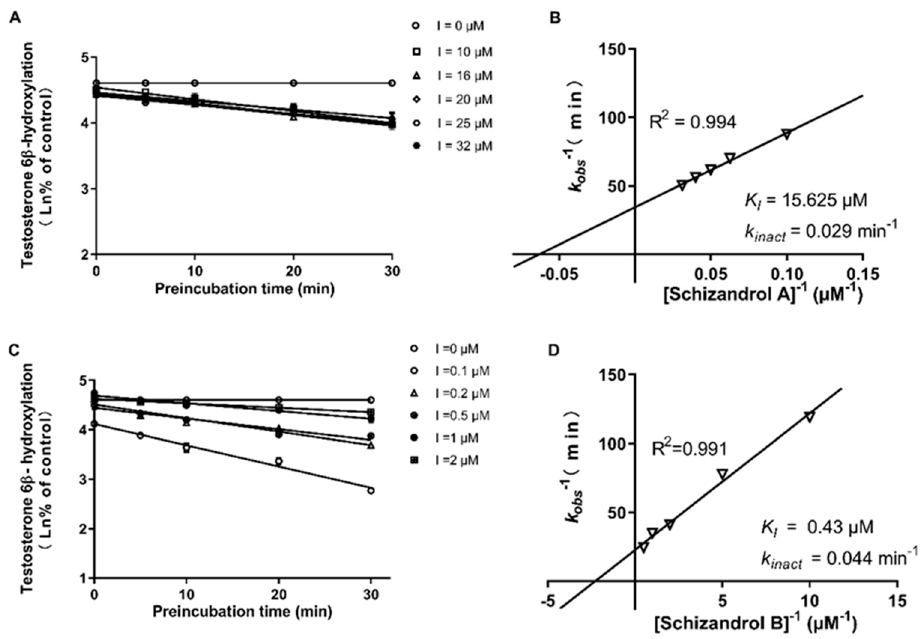
Figure 3. Dixon plots of SZA ( A , B ) and SZB ( C , D ) on CYP3A inactivation in pooled HLMs. Various concentrations of SZA (0, 10, 16, 20, 25, 32 µ M) and SZB (0, 0.1, 0.2, 0.5, 1, 2 µ M) were pre-incubated at 37 ◦ C for 0, 5, 10, 20 and 30 min in 0.1 M PBS. ( A , C ) were plotted with the log of percentages of control activity versus preincubation time. ( B , D ) were plotted with the half-life of enzyme inactivation versus the inverse of the SZA or SZB concentration. Each point represents the mean of triplicate experiments.